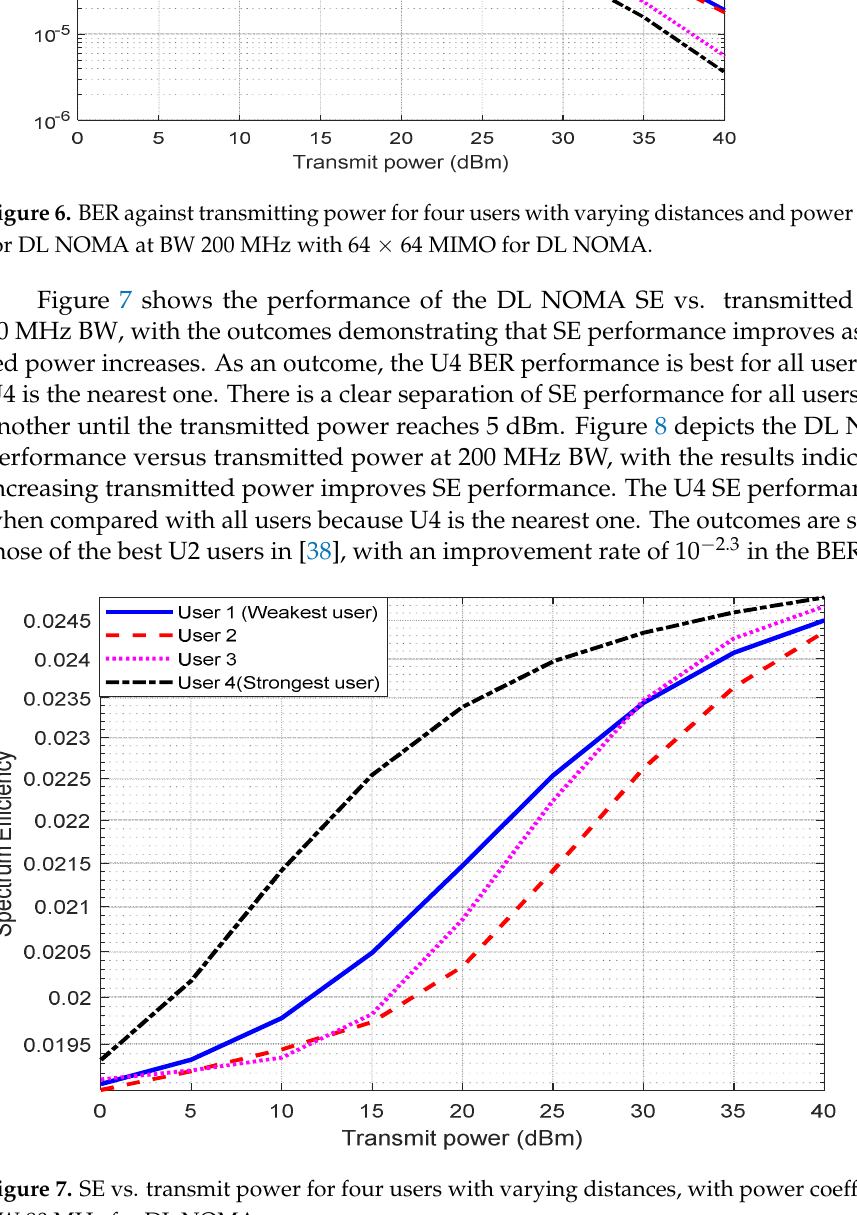
Figure 6. BER against transmitting power for four users with varying distances and power coeffi- cients for DL NOMA at BW 200 MHz with 64 × 64 MIMO for DL NOMA. for DL NOMA at BW 200 MHz with 64 × 64 MIMO for DL NOMA.